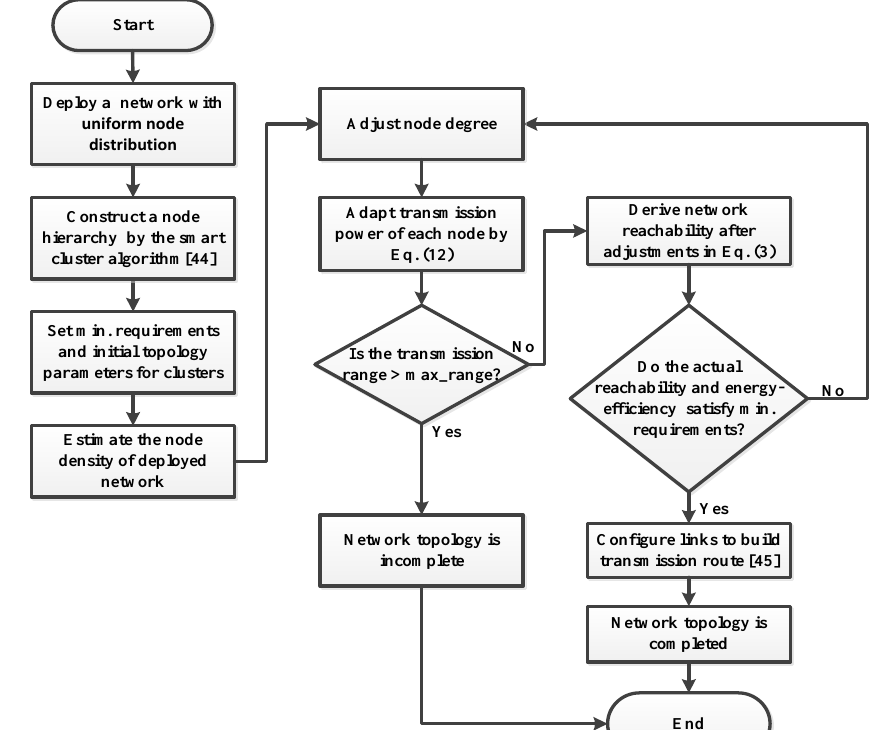
Derive network reachability after adjustments in Eq.